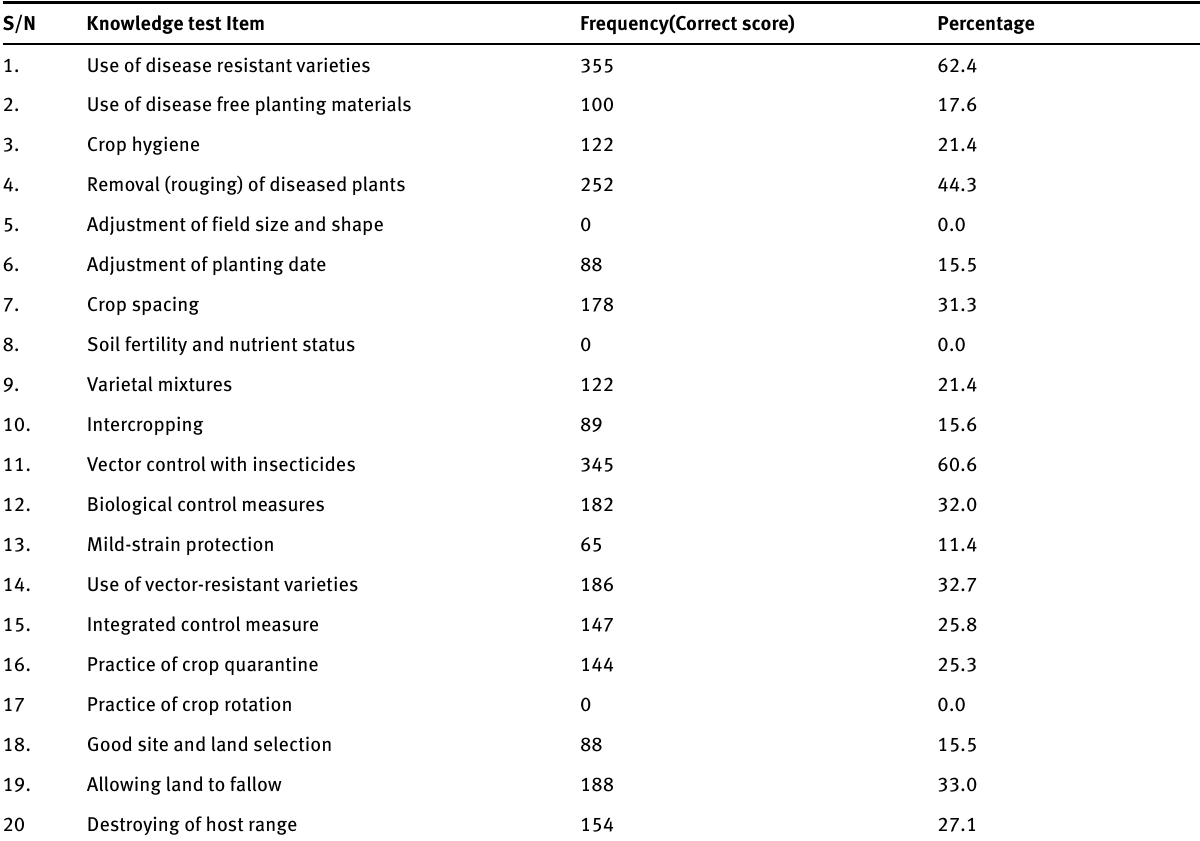
Table 4: Respondents’ Knowledge of Control of Cassava Diseases S/N